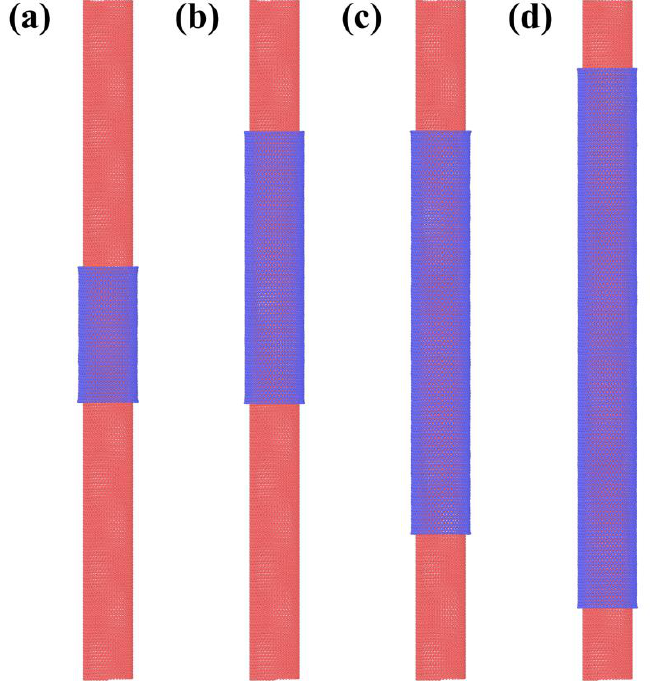
Figure 4. Wrapping (44,1) SWCNT with GNR of L = 13.38 nm, while W equals to 10.0, 20.0, 30.0 and 40.0 nm respectively from ( a – d ). The resultant twist angle is 1.1°.